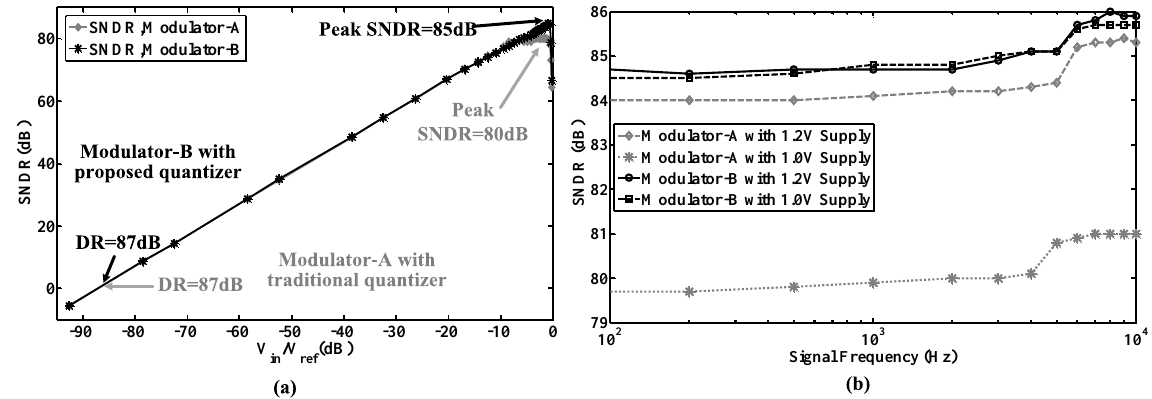
Figure 18. ( a ) Measured SNDR at different input amplitudes; ( b ) Measured peak SNDR at different frequencies and supply voltages.